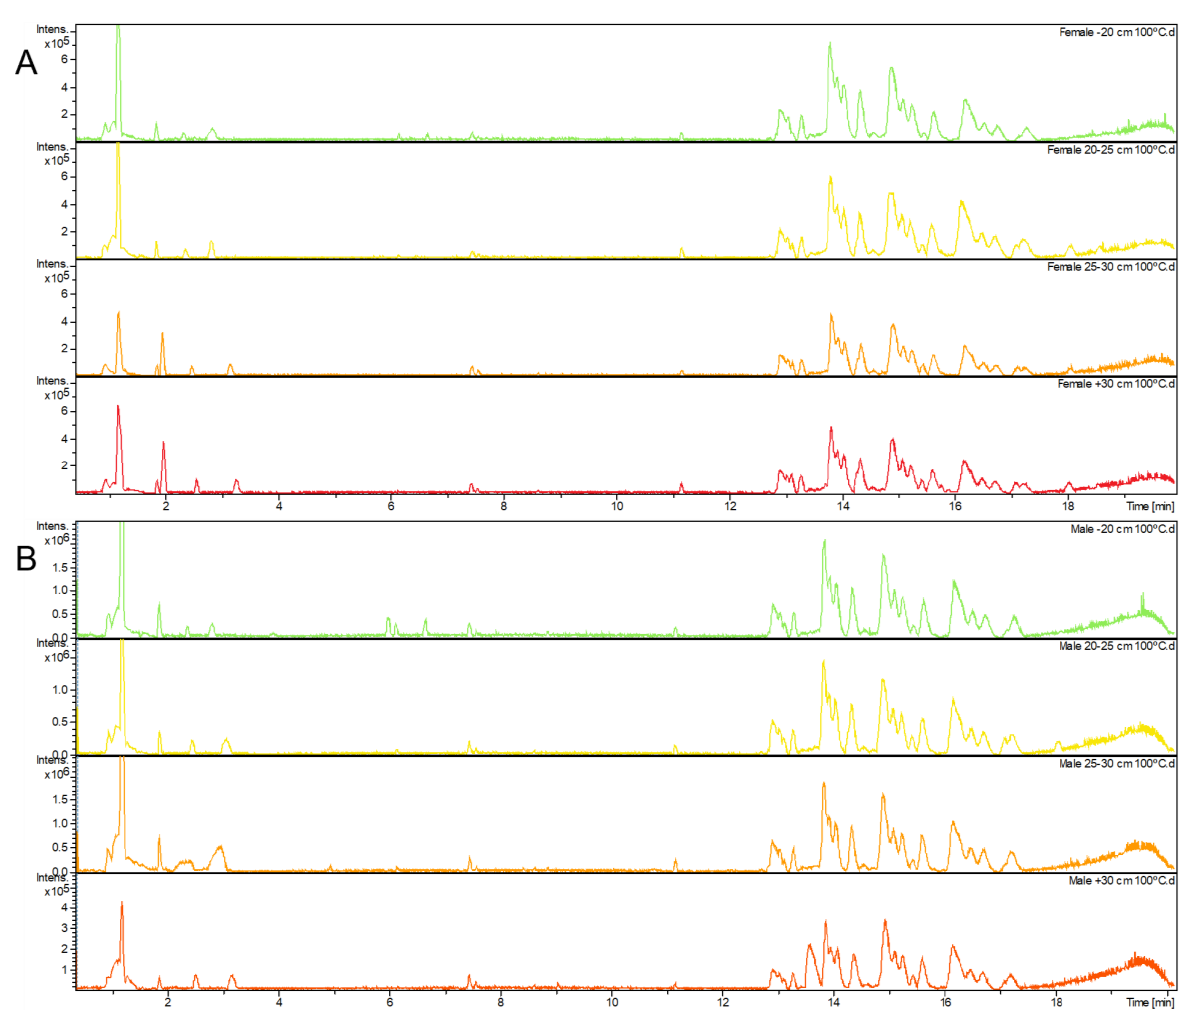
Figure 6 . Chromatographic profiles of the compounds found across four growth stages (<20 cm, 20– 25 cm, 25–30 cm and >30 cm) of female ( A ) and male ( B ) extracts of F. vesiculosus , obtained by using LC/HRMS-MS in ESI negative mode. Extracts carried out at 100 °C .